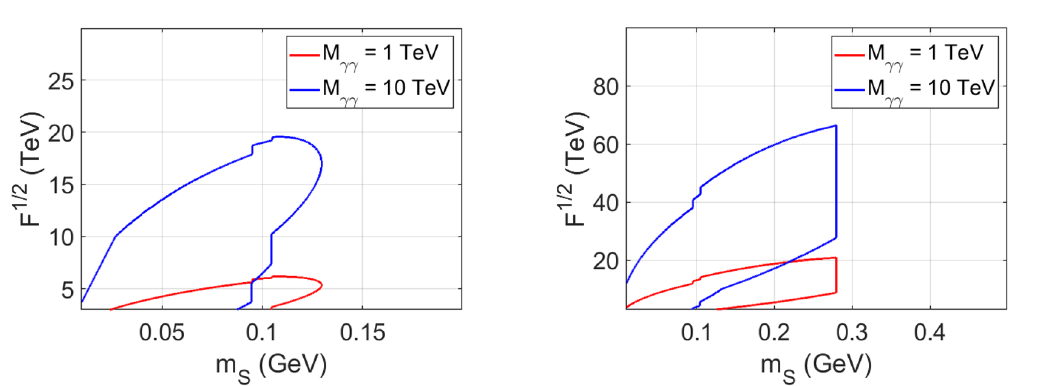
Figure 10 . Sensitivity region of FASER-I (left plot) and FASER-II (right plot) to models with scalar sgoldstino. Sgoldstinos are produced in Primakoff process and decay into a pair of photons. √ √ In the regions where F < M γγ we set M γγ = F